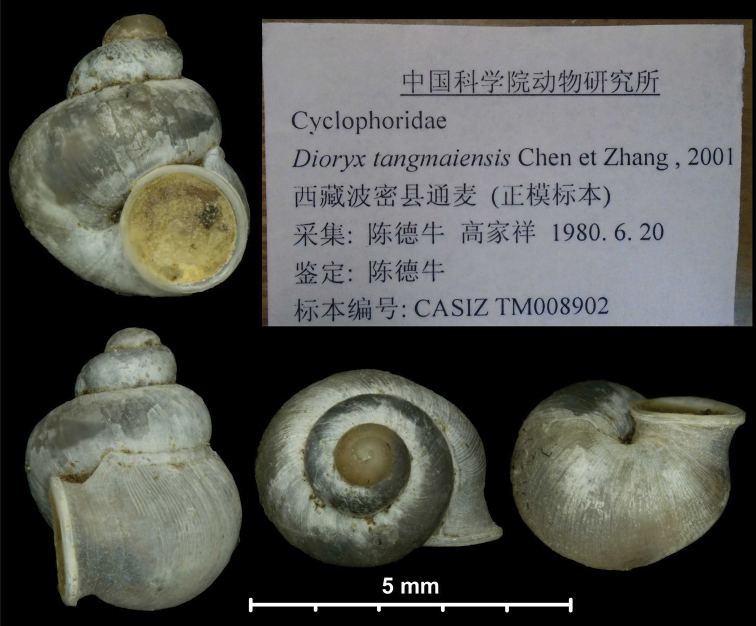
Dioryx
tangmaiensis Chen & Zhang, 2001, holotype (CASIZ TM 008902). Photographs: Kaibaryer Meng.